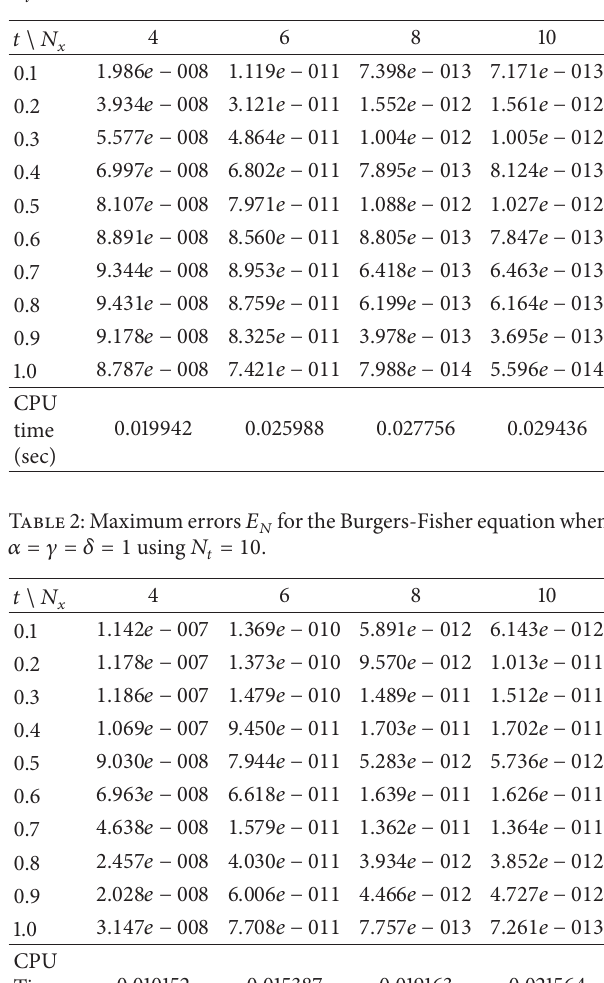
Table 1: Maximum errors 𝐸 𝑁 for Fisher equation when 𝛼 = 1 using = 10 . 𝑁 𝑡